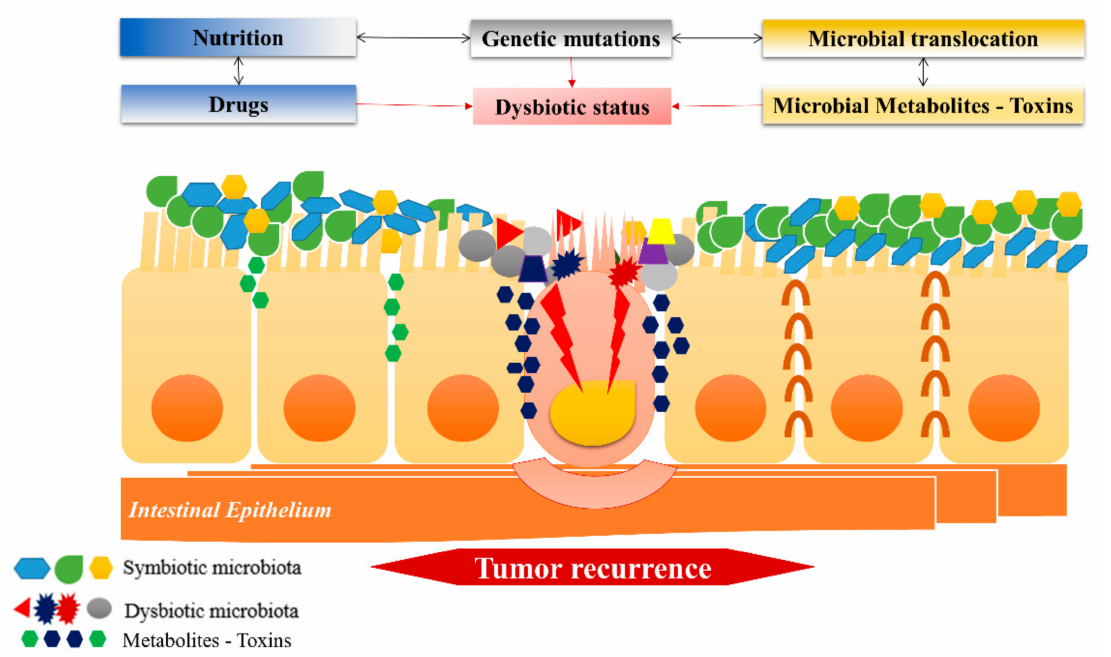
Figure 1. External factors (nutrition, medications), as well as intrinsic factors (microbial translocation and metabolites), affect commensal microorganisms ( F. prausnitzii , Bifidobacteri ) enabling bacteria associated with a higher risk of tumor recurrence ( F. nucleatus , E. faecalis , P. mirabilis , E. Coli , Abacteroides , Salmonella etc.) to prevail and modulate the intestinal microenvironment in a plenitude of ways promoting neoplastic cellular